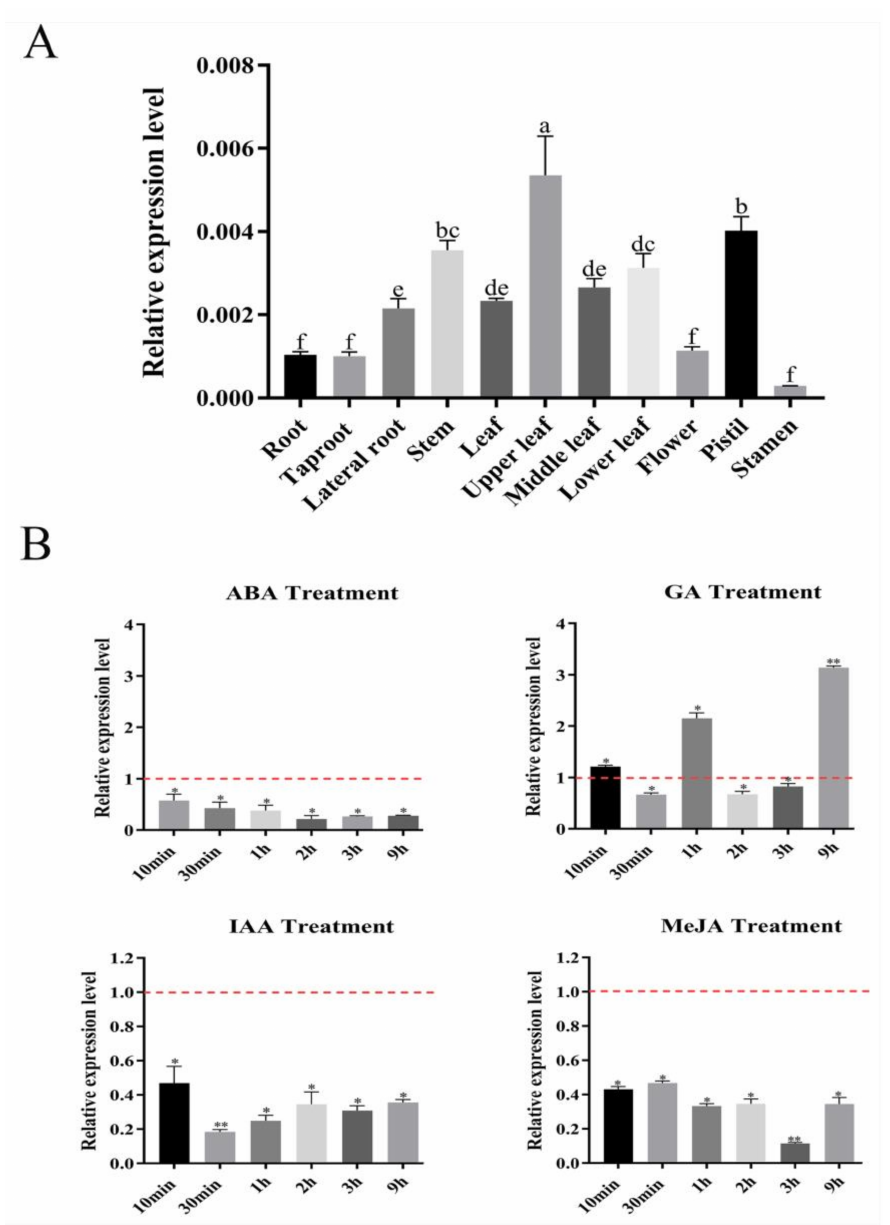
Figure 1. Expression profiles of SmSPL6 in Salvia miltiorrhiza . ( A ) The expression of SmSPL6 in different tissues. ( B ) Expression changes in response to treatment with 5 mM MeJA, 0.1 mM ABA, 0.1 mM IAA, and 0.1 mM GA 3 . All data are means of three biological replicates, with error bars indicating SD, red dotted line indicates the control which was set to 1. One-way ANOVA (followed by Tukey’s comparisons) tested for significant differences between means (indicated by different letters at p < 0.05). * and ** represent a significant difference at p < 0.05 and p < 0.01 compared with the control,